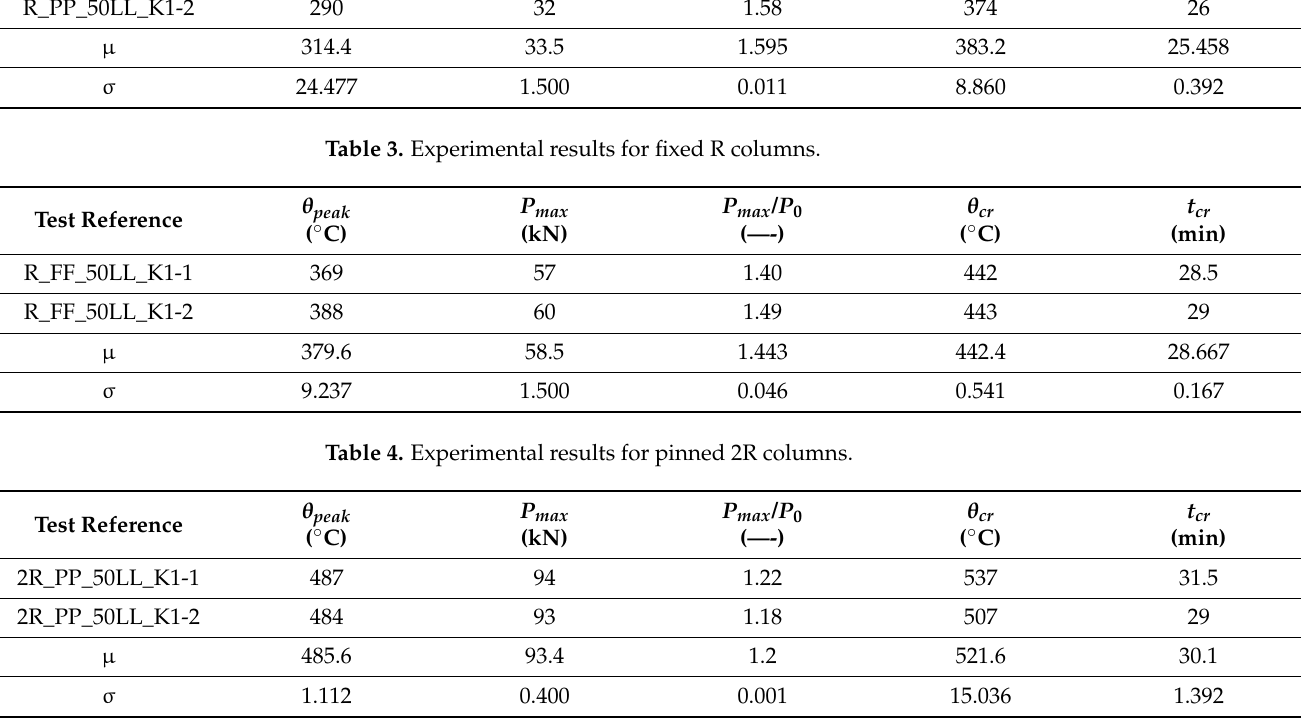
Table 5. Experimental results for fixed 2R